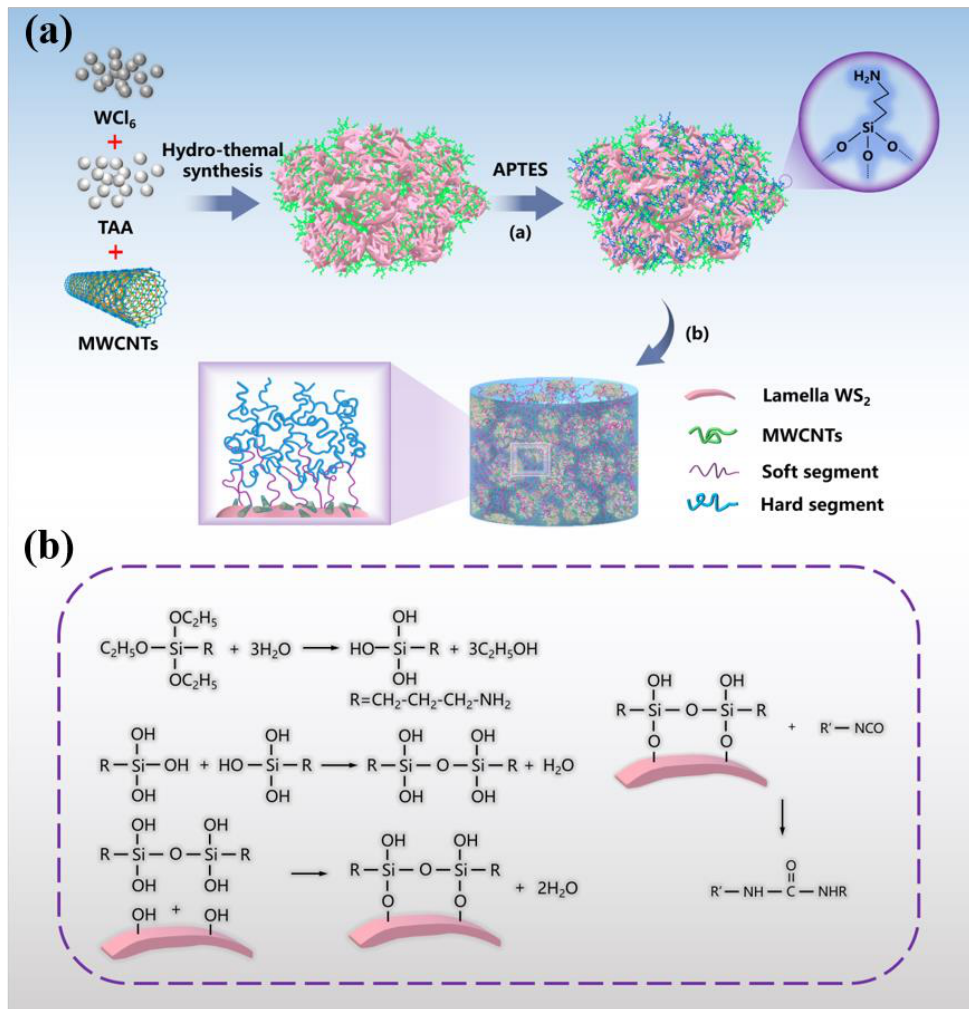
Figure 1. ( a ) Preparation of WS 2 @MWCNTs composite nanoparticles by in situ growth method, and ( b ) chemical schematic diagram of A-WS 2 @MWCNTs prepared by in situ grafting.